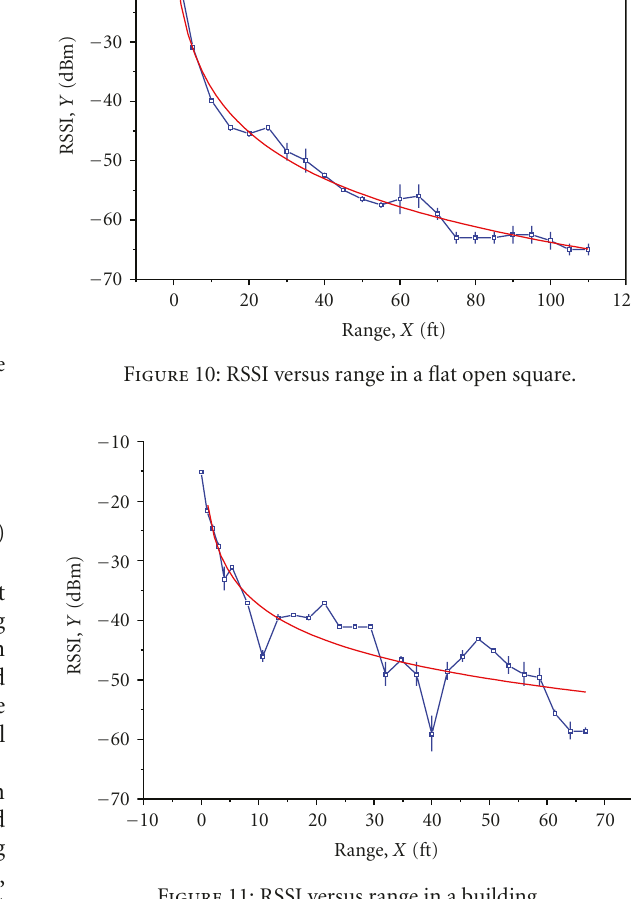
Figure 11: RSSI versus range in a building.